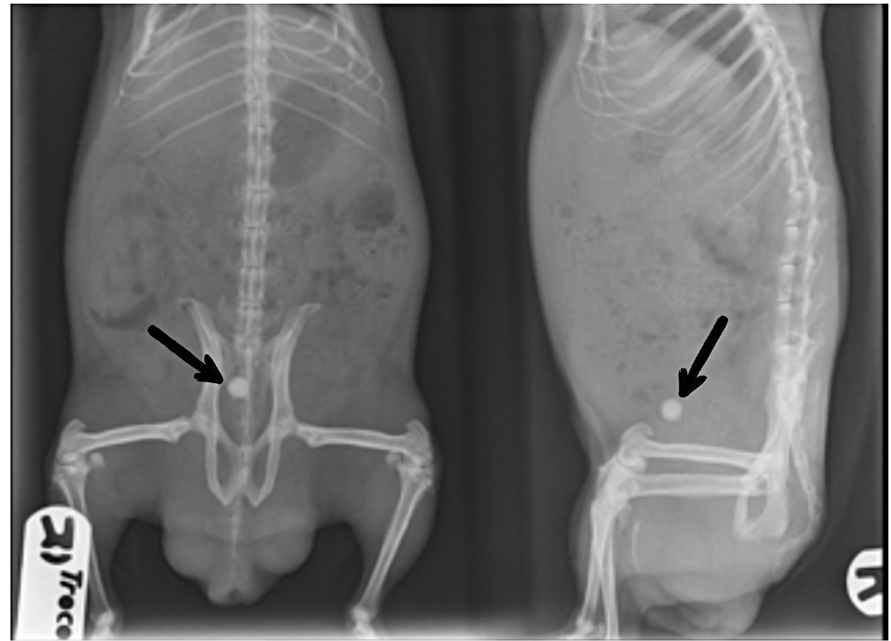
Figure 1. Radiographs of a sedated male guinea pig with an urolith in the bladder (marked with arrows) in ventrodorsal and right latero-lateral projections.